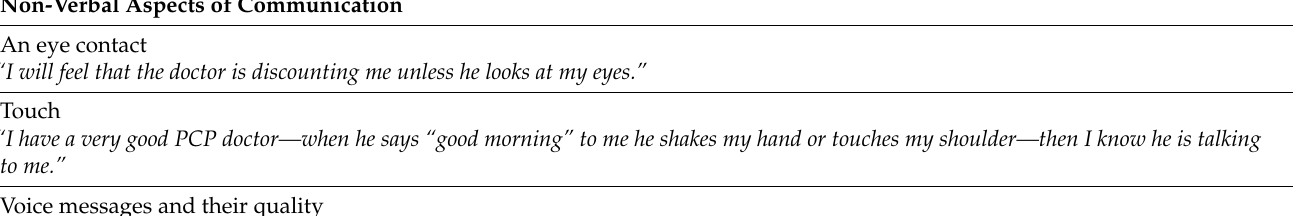
Table 3. Psychosocial competencies of staff as desired by patients with